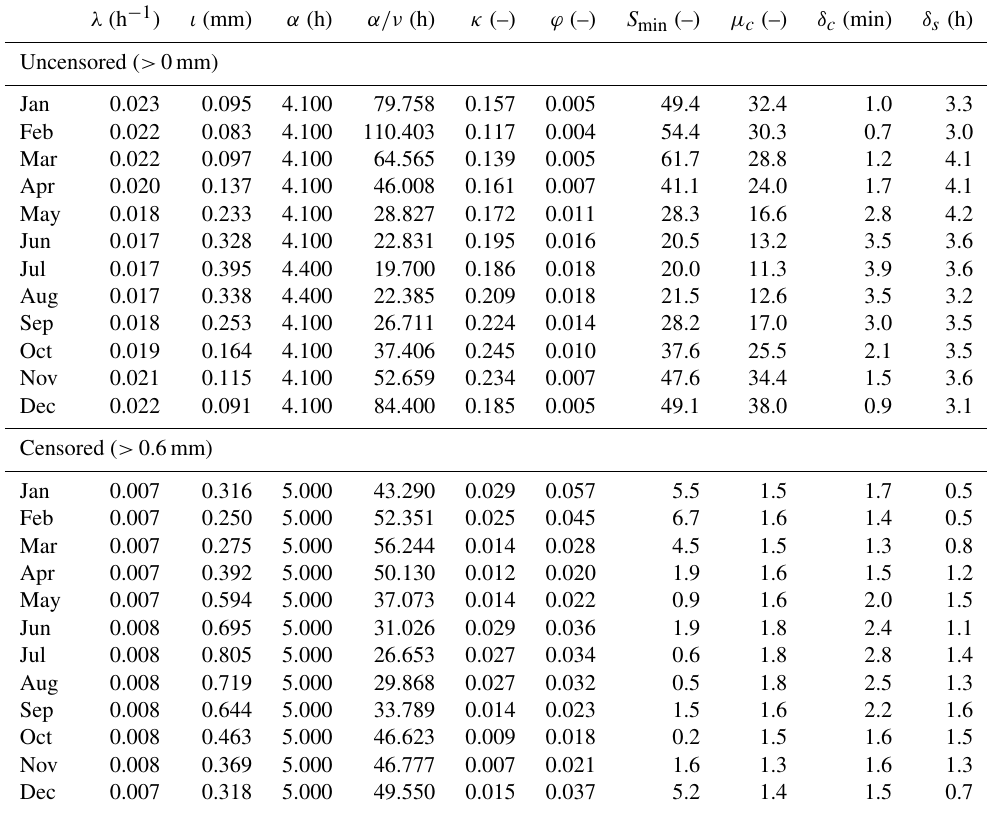
Table B2. BL1M model parameters for the Atherstone 5min